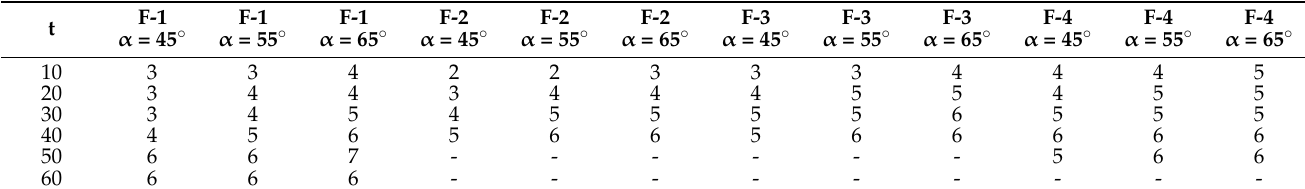
Table 3. The number of intermediate flows of different inclinations through time.